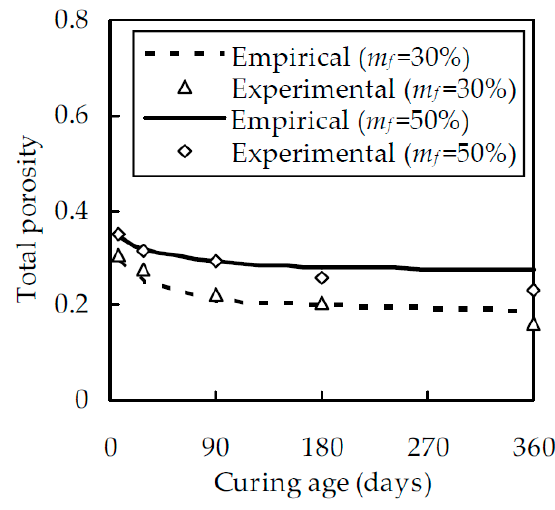
Figure 2. A comparison between the empirical formula and experimental results of Yu [36].